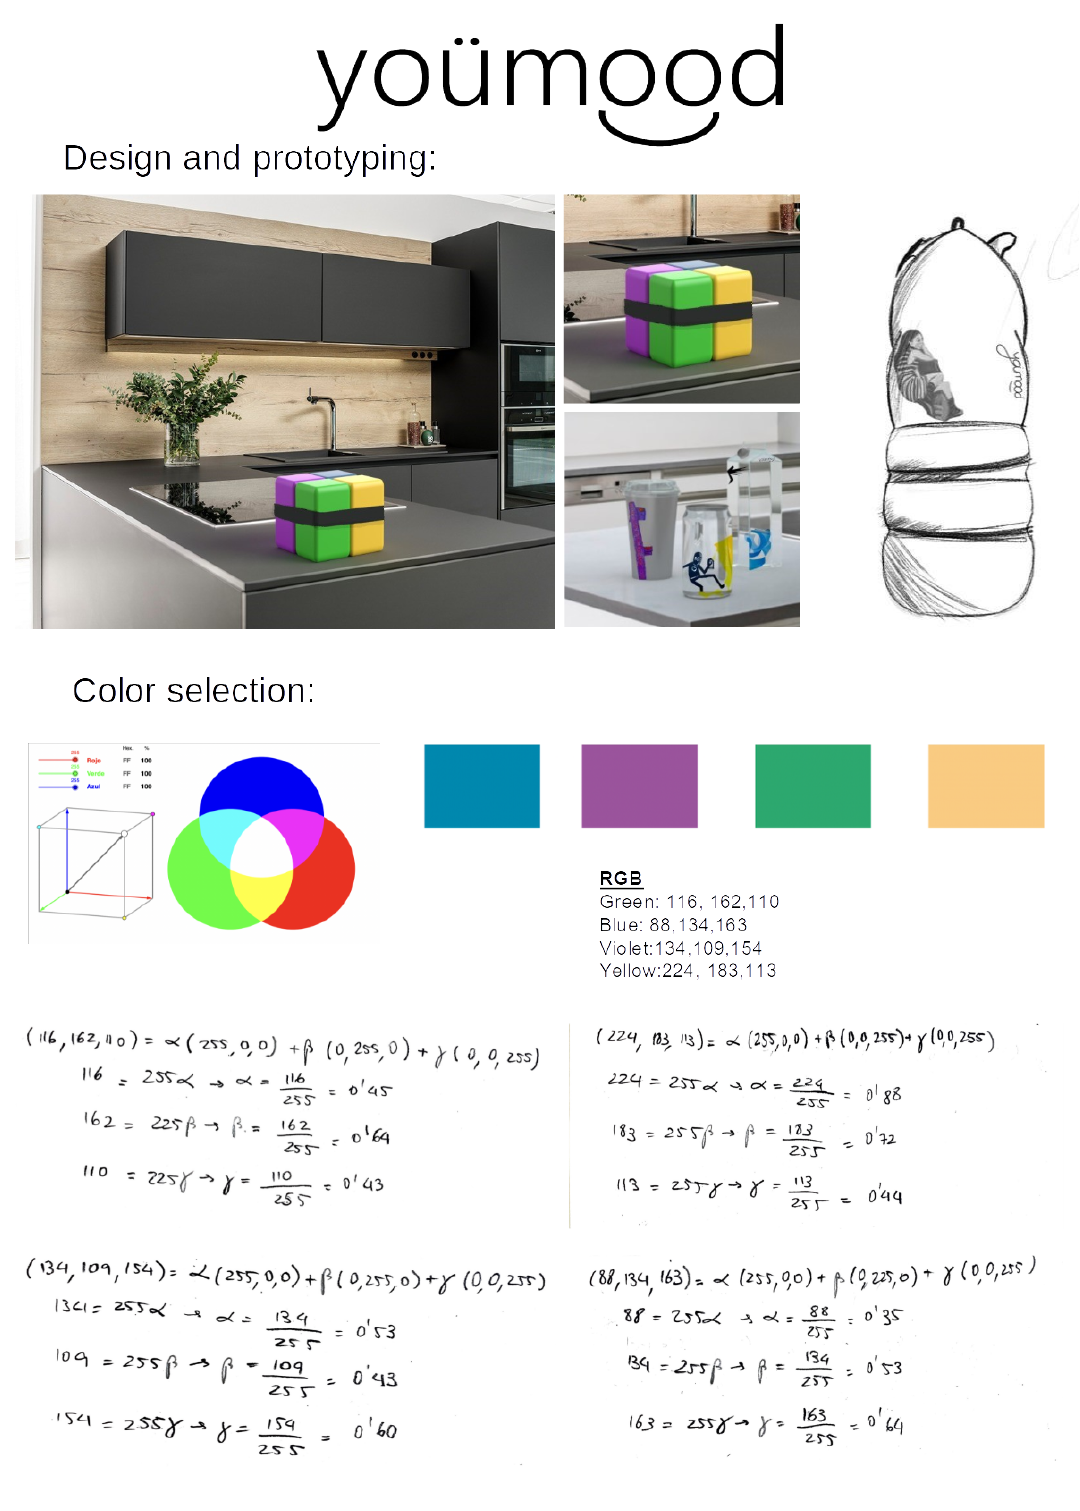
Figure A2. YOUMOOD. A product with a bottle of water where each box or bottle has a color related with art and